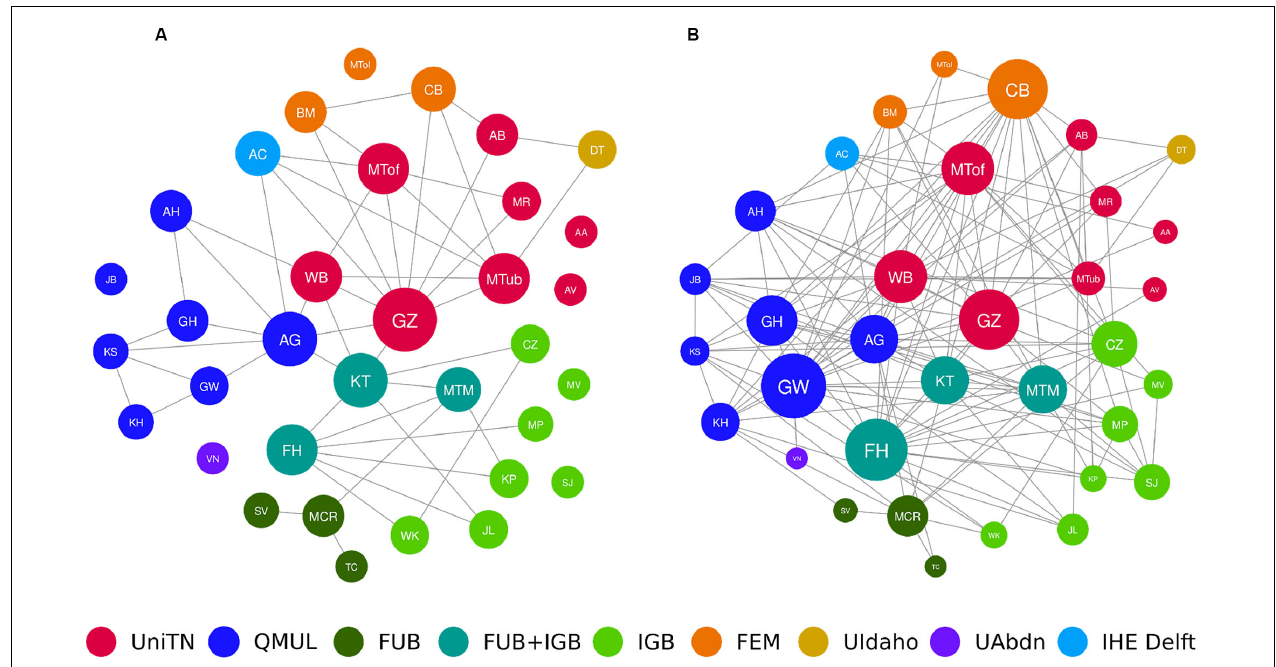
FIGURE 6 | Network maps presenting the scientific connections between supervisors: (A) before the start of the SMART EMJD, and (B) after the SMART EMJD. Node size is proportional to the relative amount of connections of the supervisor.